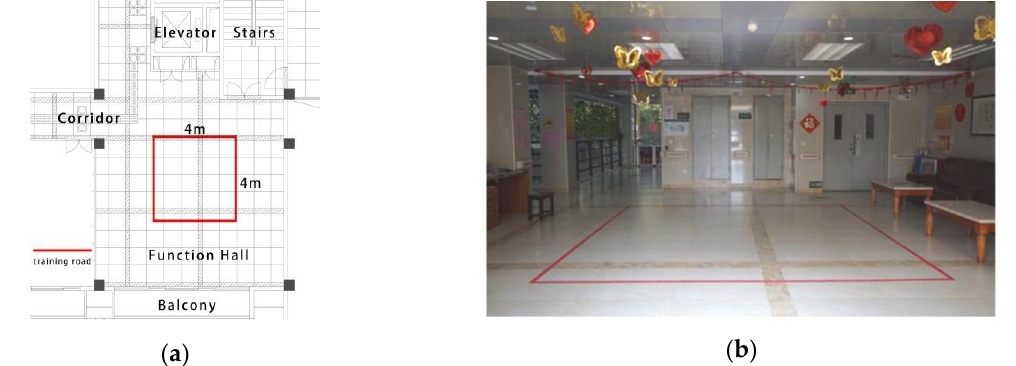
Figure 2. ( a ) The layout of the indoor solid ground; ( b ) a perspective view of the indoor solid ground.